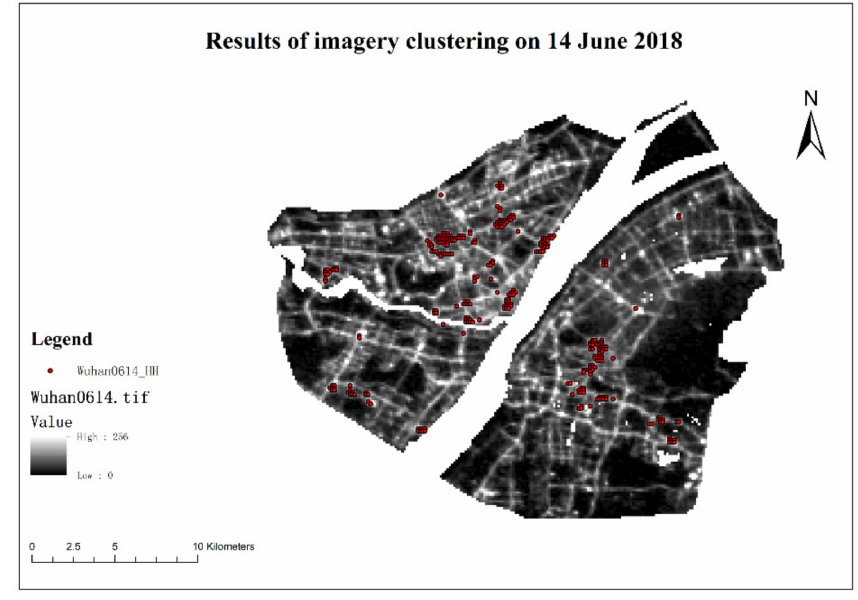
Figure 5. Results of clustering of the June imagery of